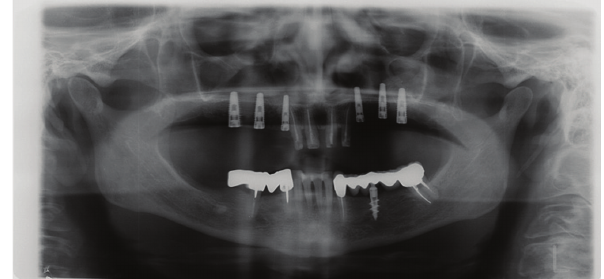
Figure 12: Panoramic radiograph after implant